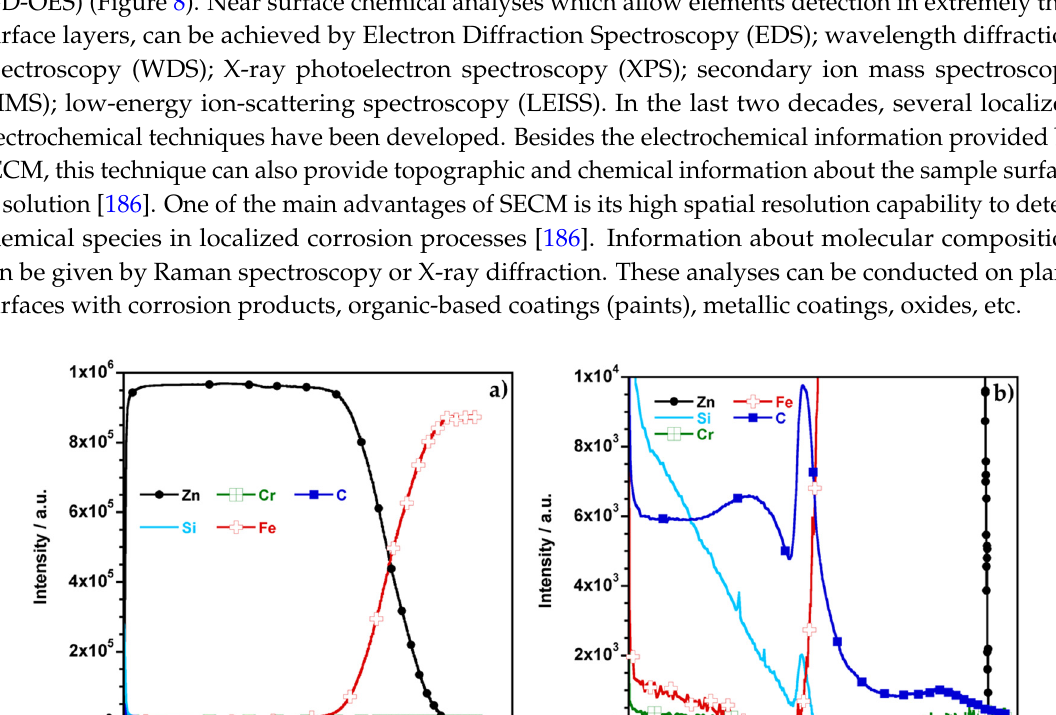
Figure 7. Cross ‐ sectional observation of HDGS coated with an organic ‐ inorganic hybrid (OIH) coating obtained by sol ‐ gel method. Figure 7. Cross-sectional observation of HDGS coated with an organic-inorganic hybrid (OIH) coating obtained by sol-gel method.